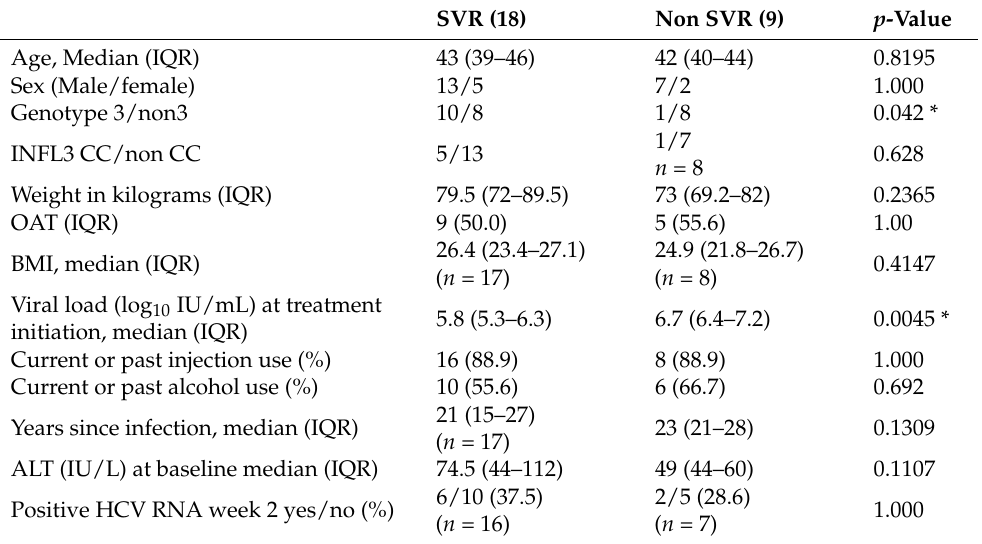
Figure 4. Baseline viral load according to SVR12 status. Abbreviations: sustained virological response (SVR). Table 2. Baseline characteristics in relation to SVR status for all patients in the mITT group for both phases of the 4RIBC study who received four weeks’ treatment with GLE/PIB +